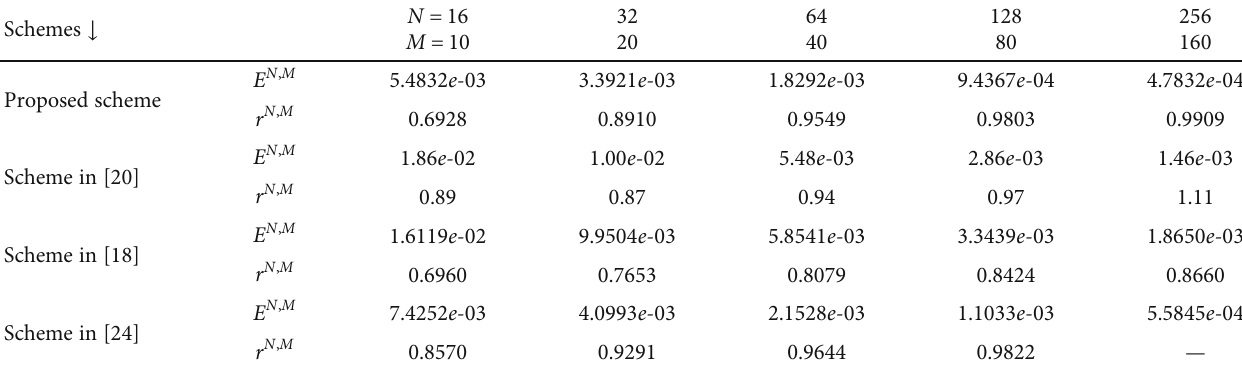
Table 5: Comparison of uniform error and uniform rate of convergence of Example